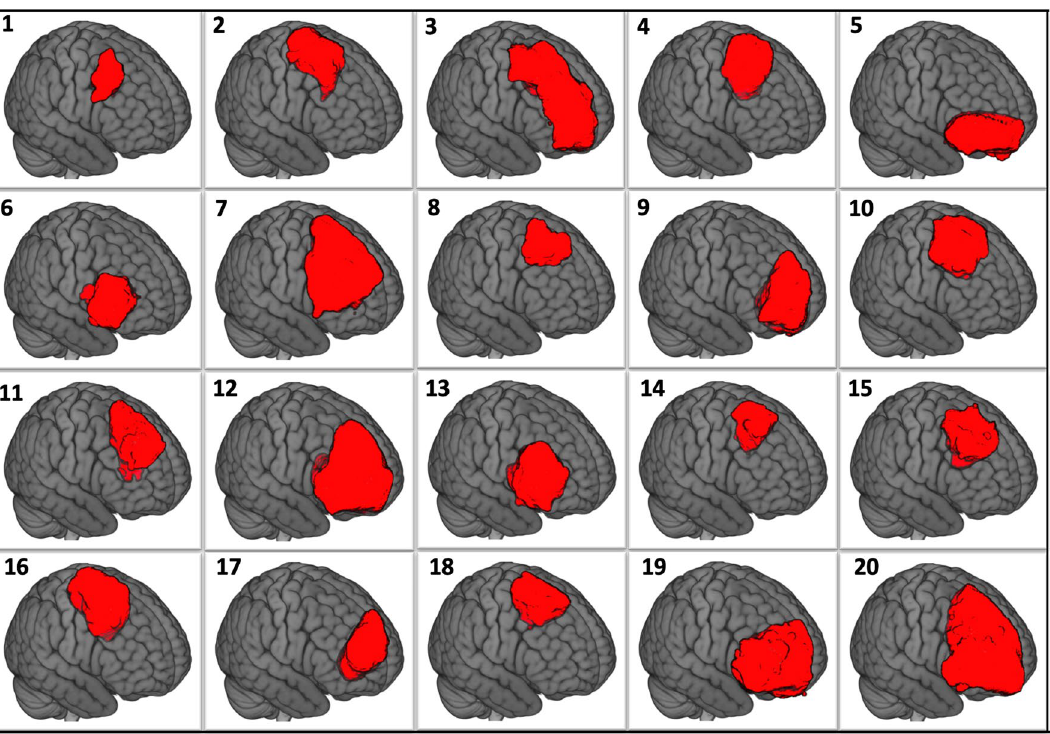
Figure 1. Surgical cavities for the 20 cases after registration in the MNI